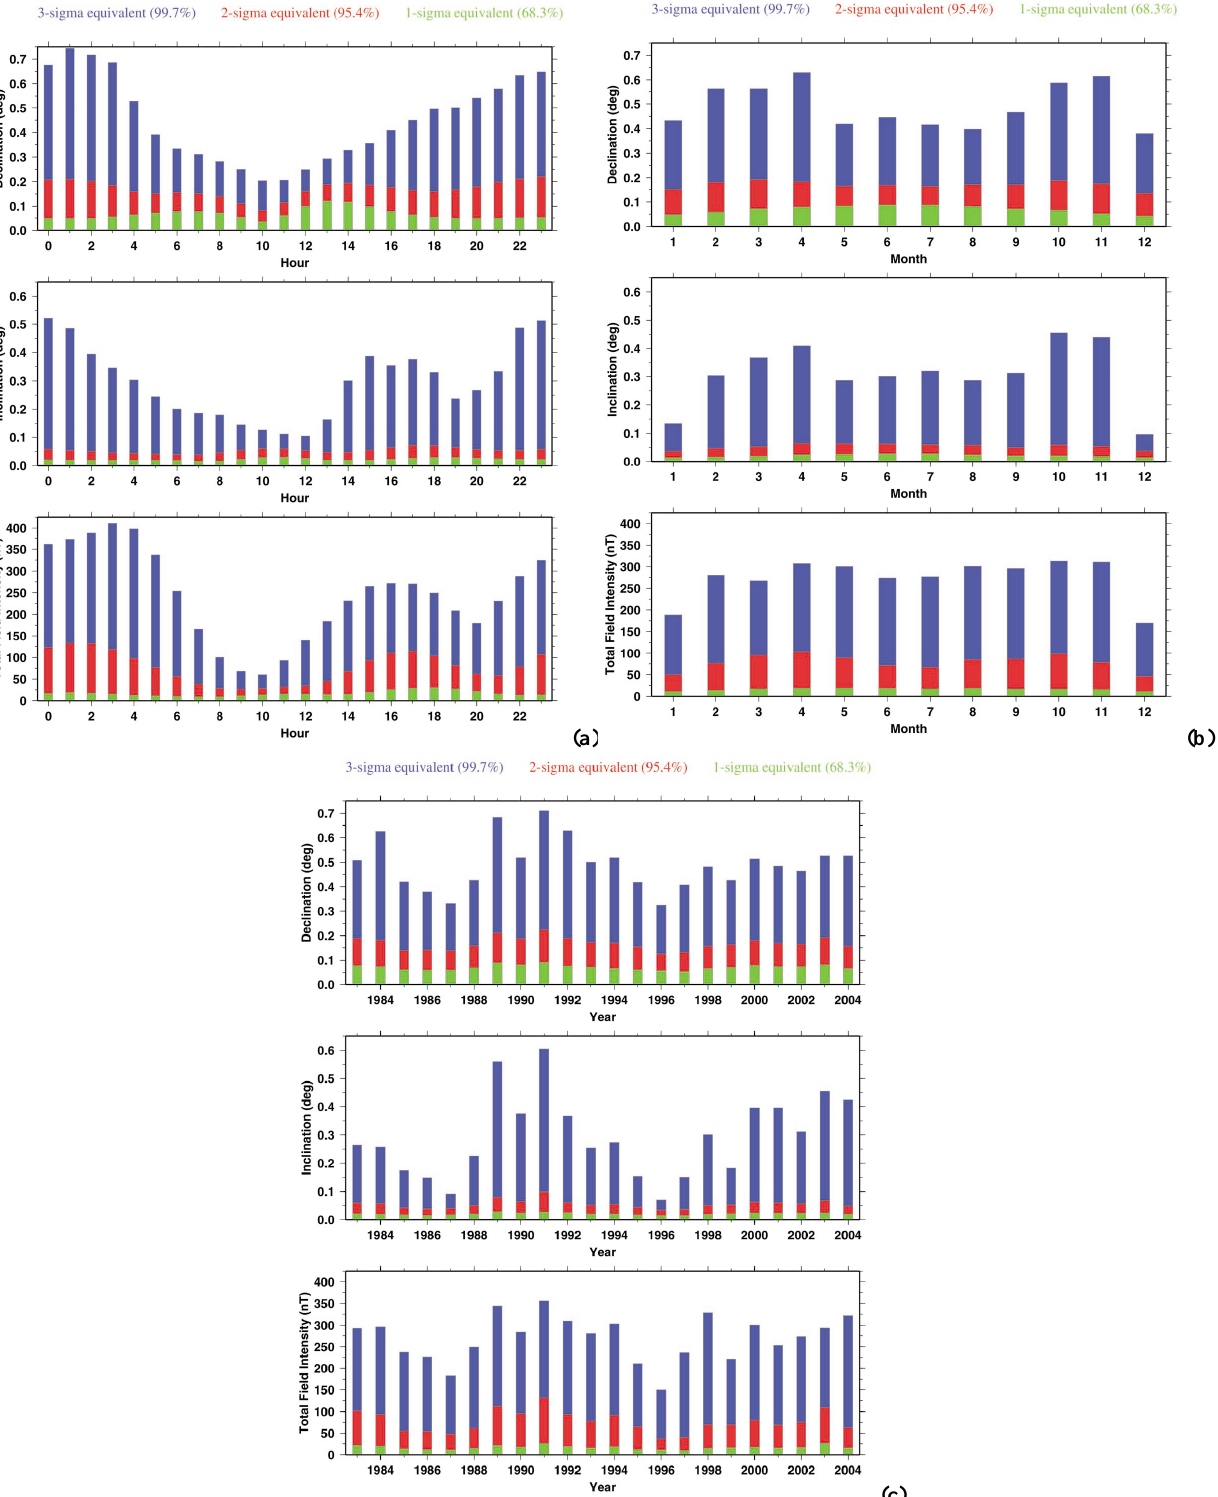
Fig. 1. Three histograms showing errors associated with the external field by hour (a) , showing local time variations; by month (b) , showing seasonal variations; and by year (c) , showing solar cycle variations. For each, three confidence levels are shown: 1 σ equivalent (68.3%) in green, 2 σ equivalent (95.4%) in red and 3 σ equivalent (99.7%) in